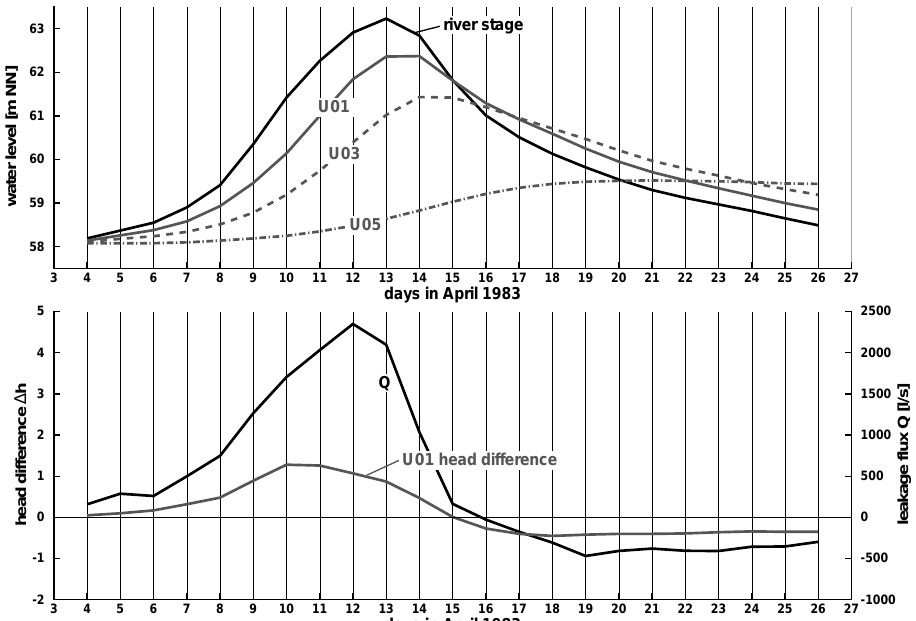
Figure 6. Hydrograph of the Rhine gauge (in meters above official sea level reference m NN) and three groundwater observation points with different distances to the river bank, respectively (values taken from [12]); leakage flux for the 1 km broad profile “Urmitz” as day-averaged values (values taken from [12]) and the head difference for the observation point located at the bank. Table 2. Distance of groundwater observation points to the river bank for the observation well chain near Urmitz (derived from